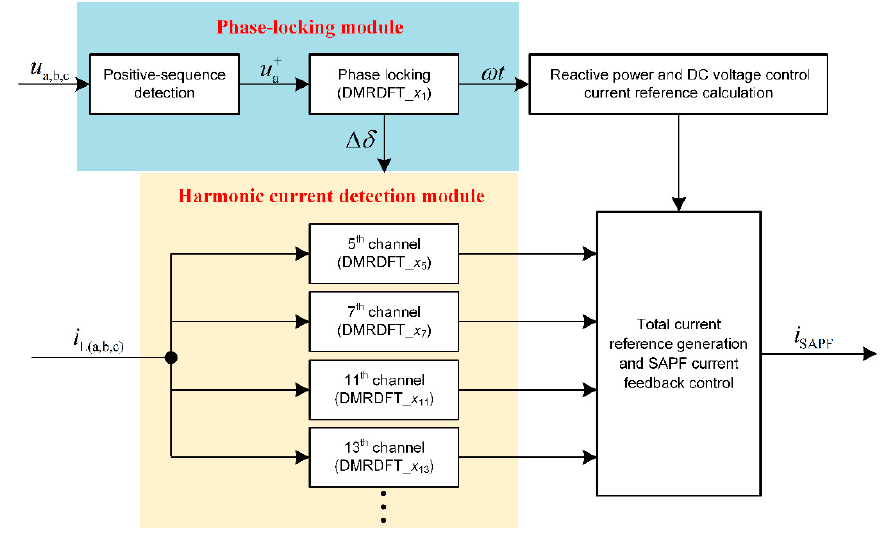
Figure 2. The proposed shunt active power filter (SAPF) control scheme.